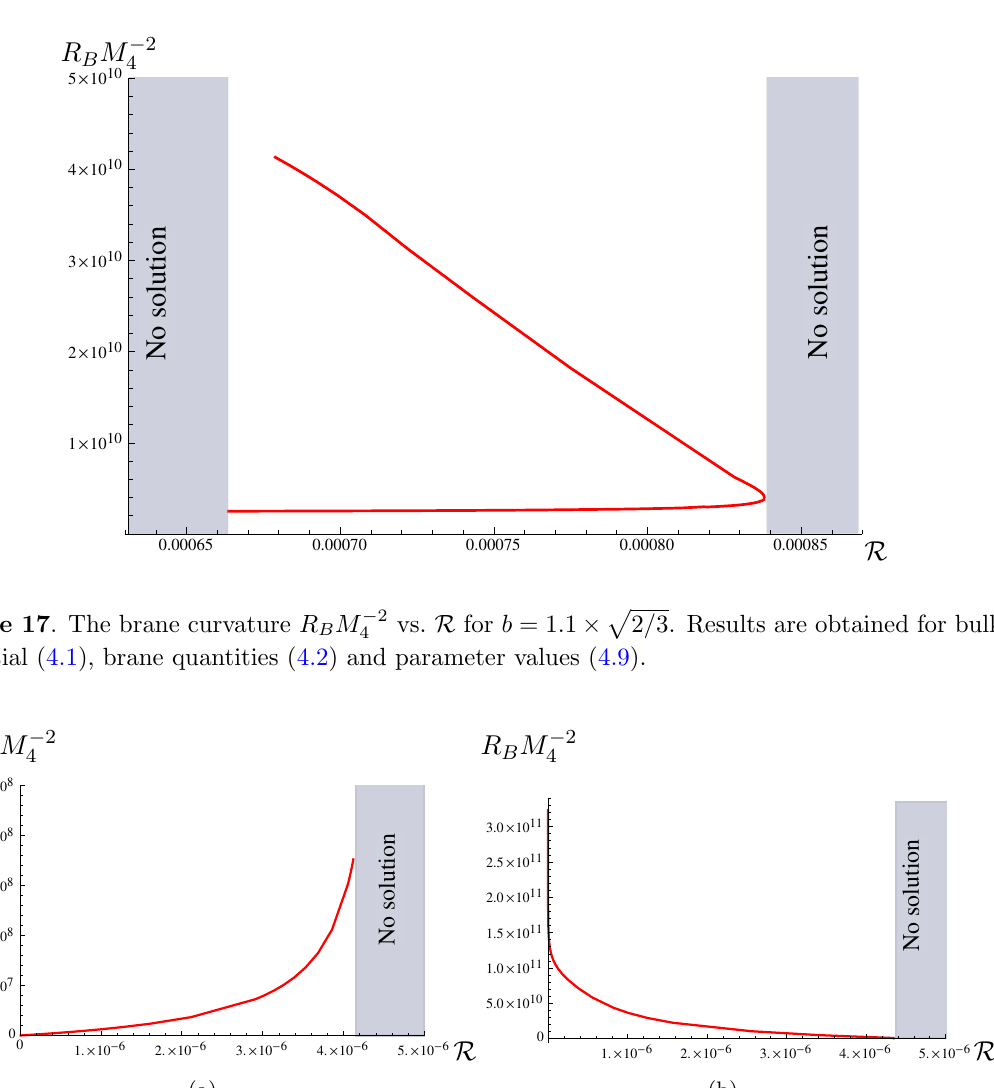
Figure 18 . The brane curvature R B M (cid:0) 2 potential (4.1), brane quantities (4.2) and parameter values (4.9). The plots (a) and (b) exhibit results for the two branches of solutions